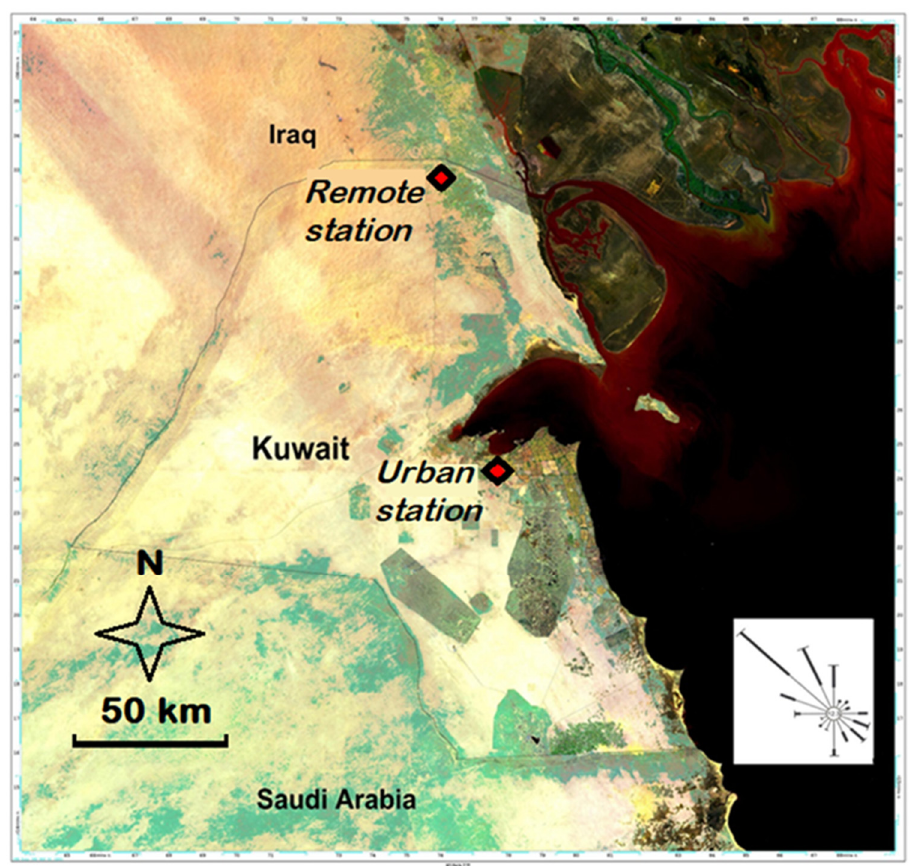
Figure 1. Location of the remote and urban aerosol sampling stations and wind rose for Kuwait